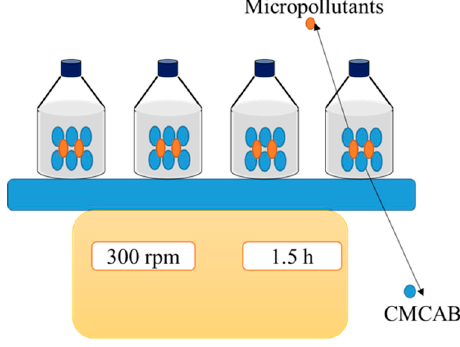
Figure 2. Schematic of experiments.